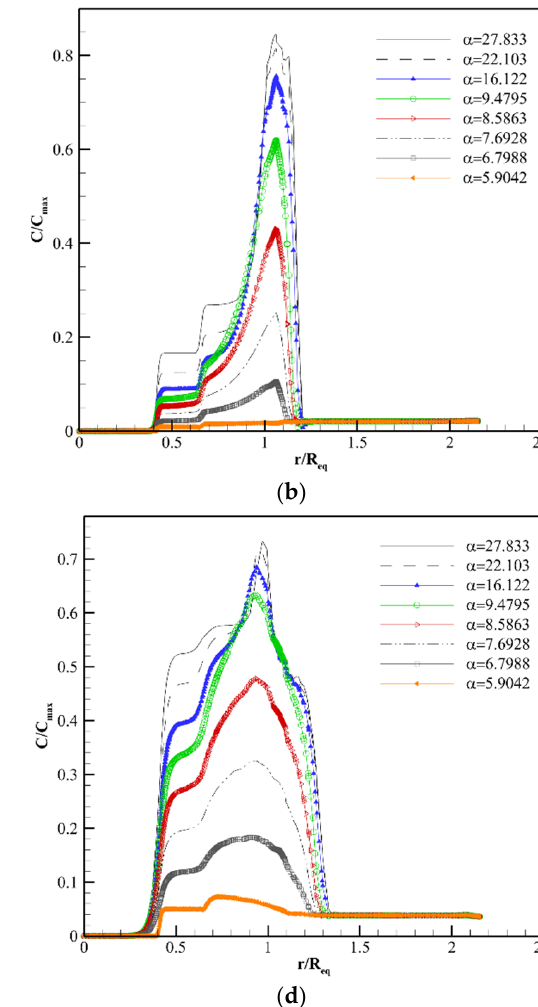
Figure 10. Distribution of 2 ( ) F ab ′ concentration along line 1. ( a ) 1 h post-injection. ( b ) 8 h post- injection. ( c ) 24 h post-injection. ( d ) 72 h post-injection.